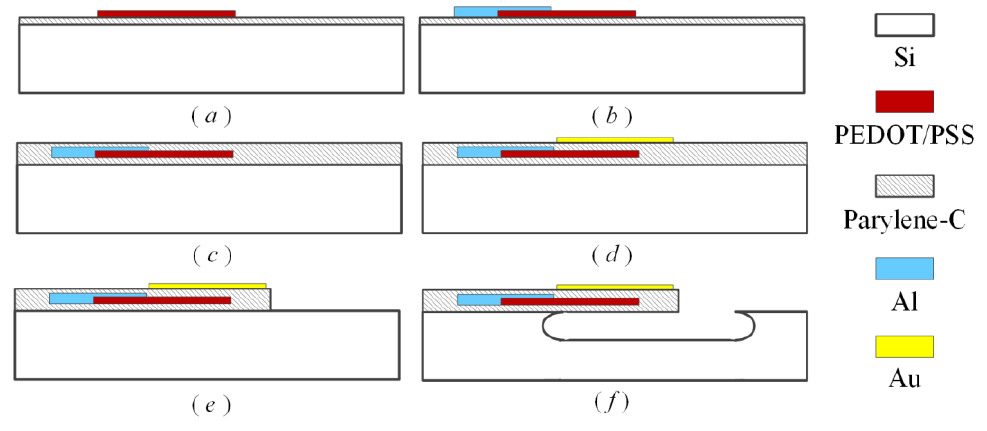
Figure 2. The fabrication processes of the proposed flexible micro-cantilever with PEDOT/PSS piezoresistor.